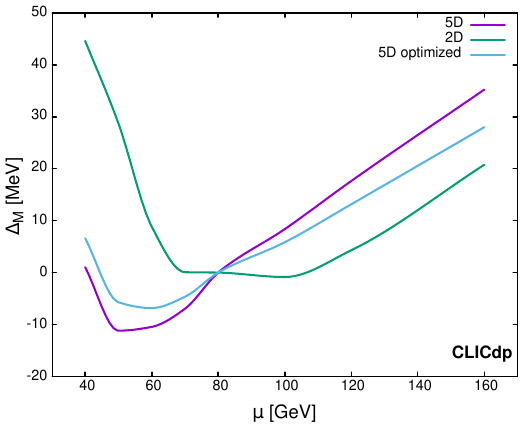
Figure 17 . Dependence of the shift in the average top-quark mass extracted from the fit to the threshold scan data on the variation of the QCD renormalisation scale parameter, µ , used for the generation of the pseudo-experiment data sets. Compared are results obtained from the 2-D and 5-D fits to the reference scan scenario and the 5-D fit to the scan optimised for mass and with